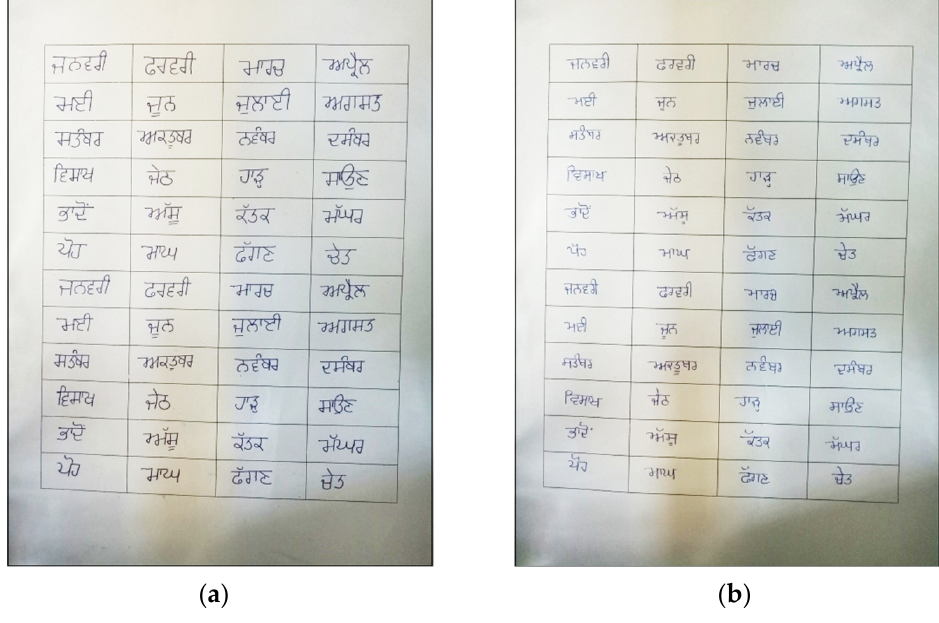
Figure 2. ( a ) Sample sheet from writer 1; ( b ) sample sheet from writer 2.